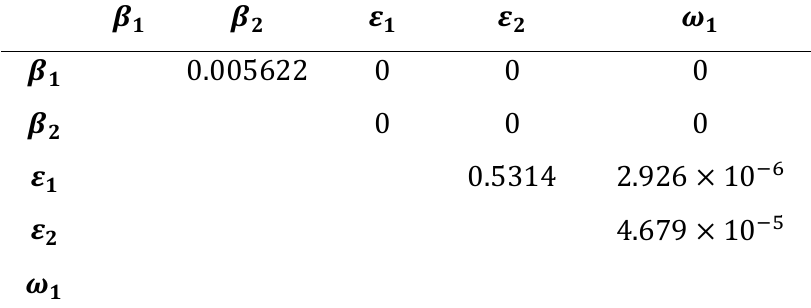
Table 4. Pairwise PRCC Comparisons (FDR Adjusted p-values)